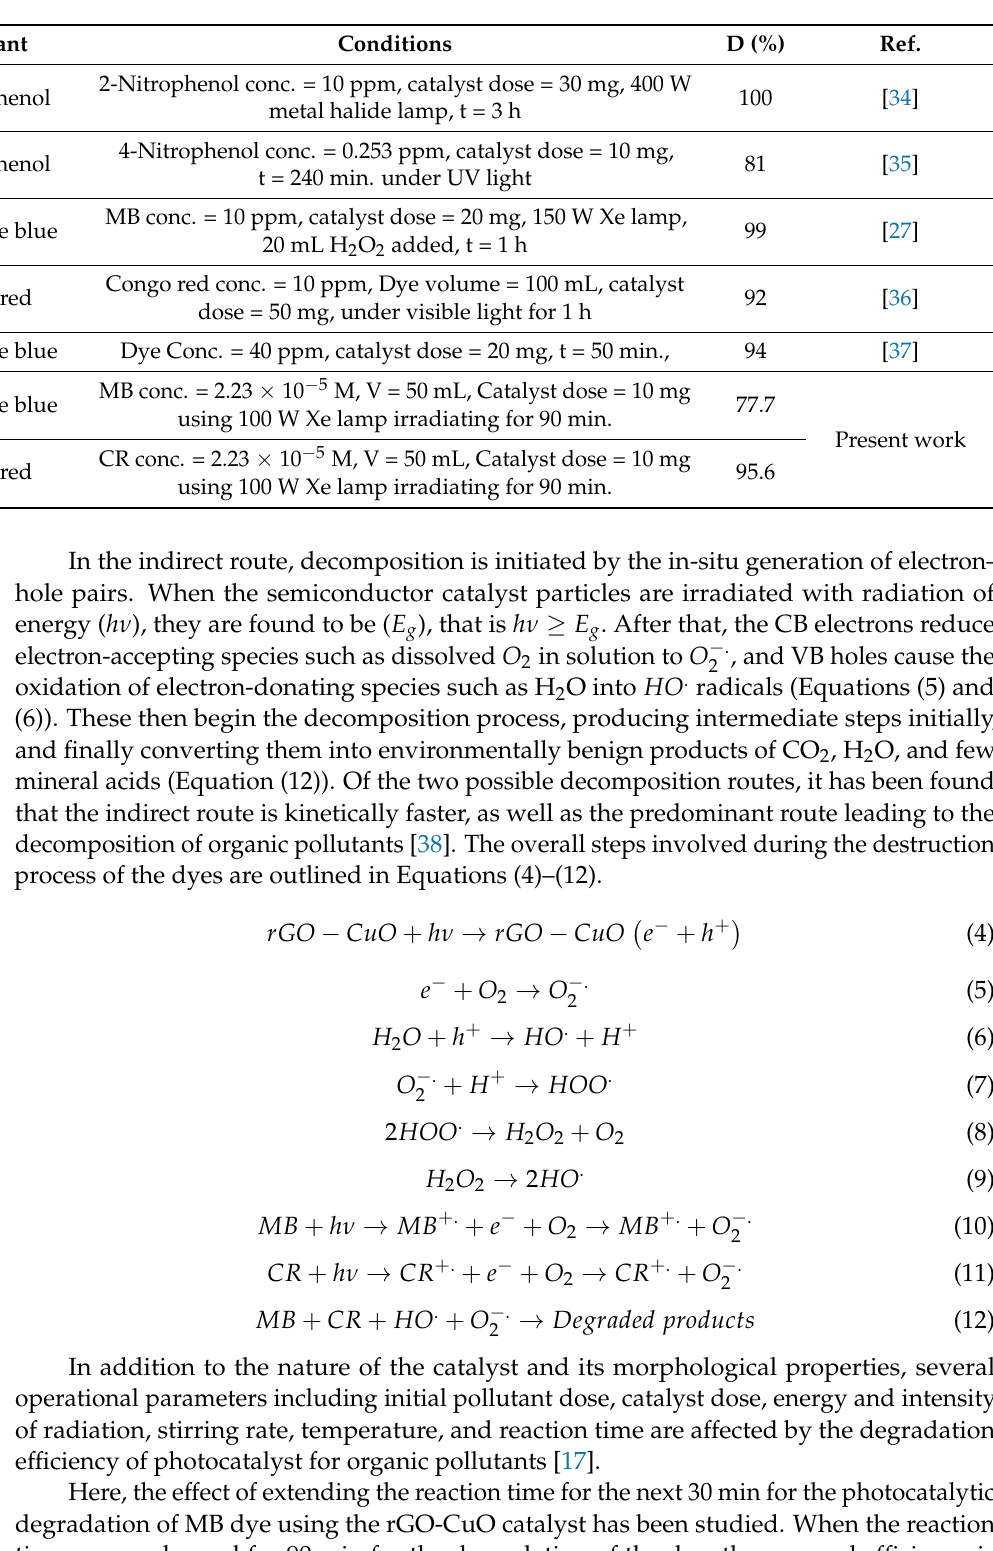
Table 3. Comparison of photocatalytic degradation performance of rGO-CuO nanocomposites for different organic pollutants with result in this